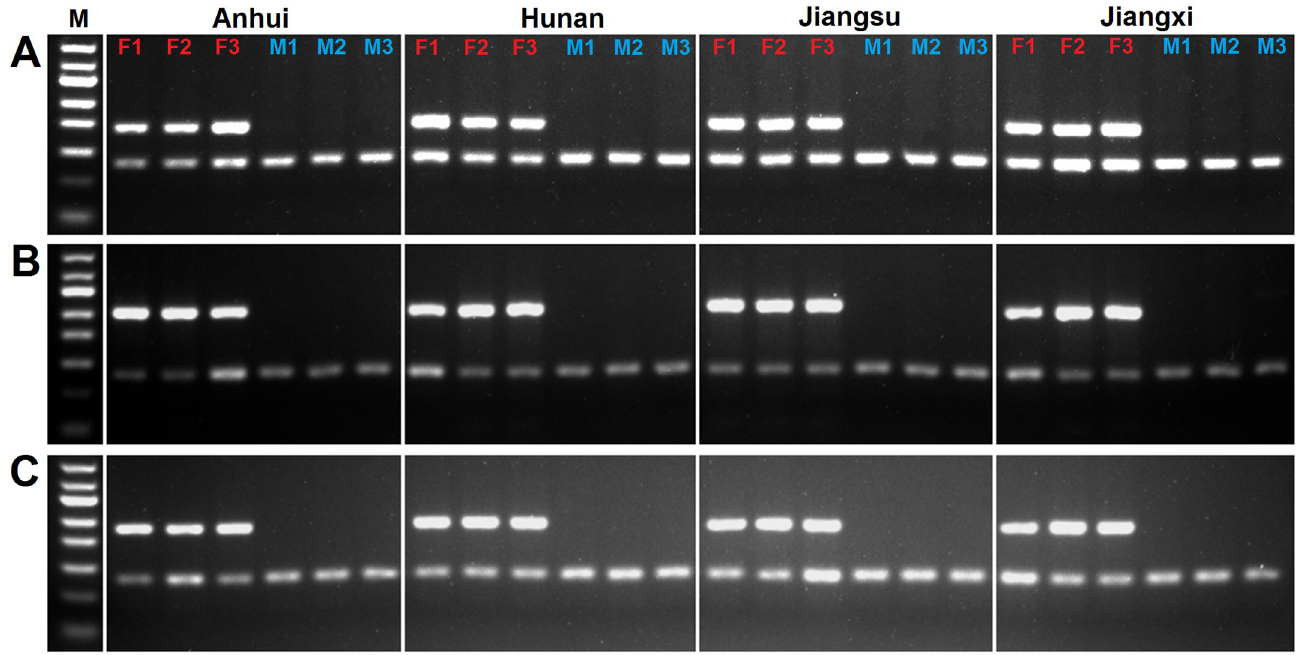
Fig 3. Three W chromosome-specific genes are useful as sex biomarkers of S . japonicum in different geographical populations. (A) Duplex PCR analysis of SjF4 and PSMD4 . (B) Duplex PCR analysis of SjF6 and PSMD4 . (C) Duplex PCR analysis of SjF9 and PSMD4 . The upper bands correspond to W chromosome- specific gene amplifications and the lower bands correspond to PSMD4 amplifications. F1–3 represent biological triplicates of genomic DNA from adult females and M1–3 represent biological triplicates of genomic DNA from adult males. M represents a 50-bp DNA ladder marker.